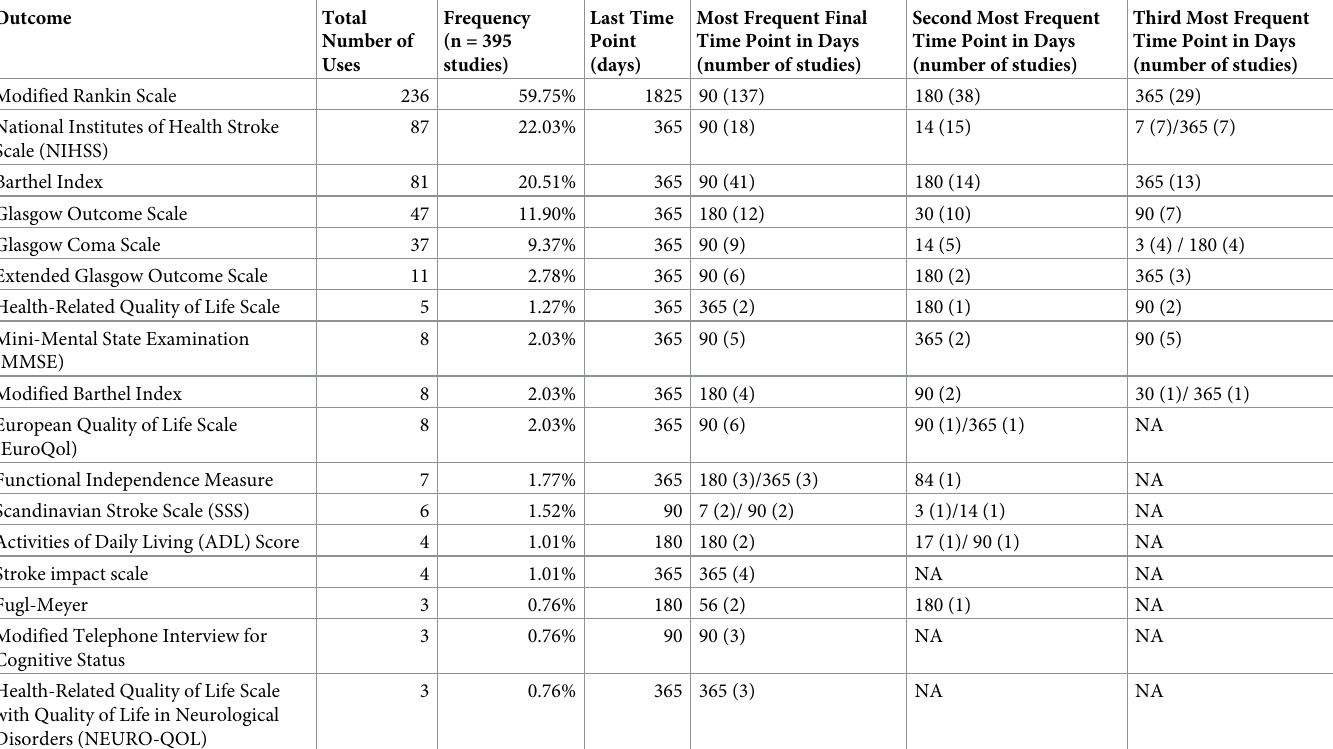
Table 1. Frequency of outcome measurement tool utilisation and frequency of final time point for each outcome measurement tool utilized in more than three